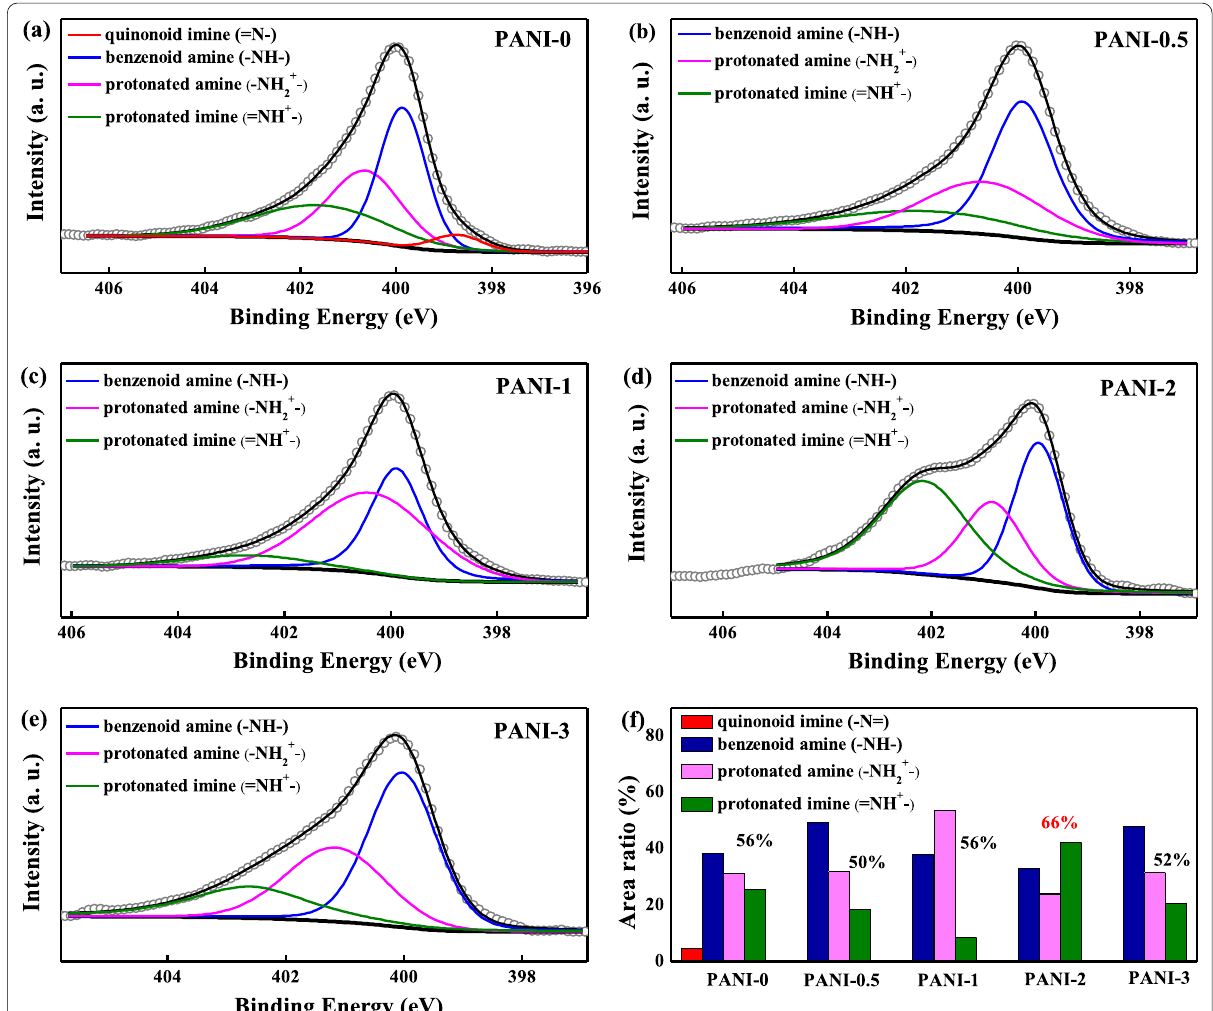
Fig. 6 XPS spectra of N 1 s spectrum for a PANI-0, b PANI-0.5, c PANI-1, d PANI-2, e PANI-3 porous films, and f the ratio of nitrogen species to total nitrogen content for N 1s